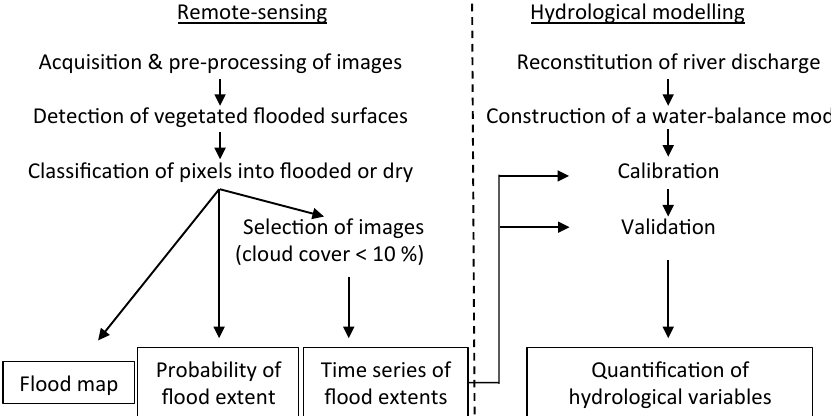
Fig. 4. Workflow diagram.